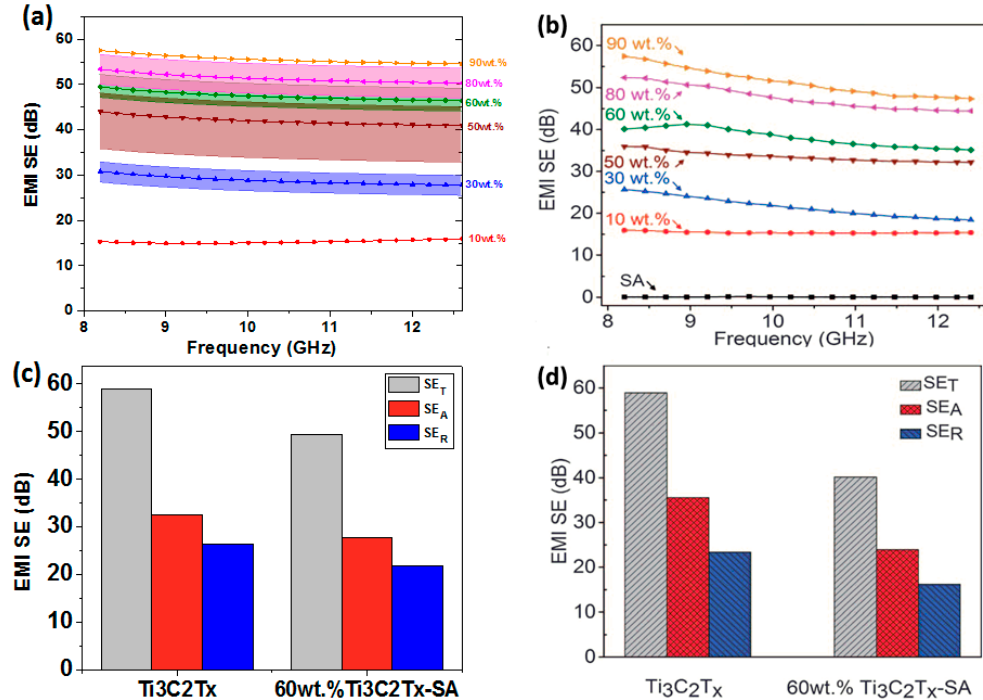
Figure 3. ( a ) Calculation of EMI shielding effectiveness of Ti 3 C 2 T x -SA composites with different concentrations, whose thickness and conductivity are adapted from Ref. [8]. The color ribbons account for the effect from the noticeable variations of conductivity measurement in Reference [8]. ( b ) Experimental results of EMI shielding effectiveness of Ti 3 C 2 T x -SA composites with different concentrations in Reference [8]. Reprinted with permission from AAAS. ( c ) Calculation of